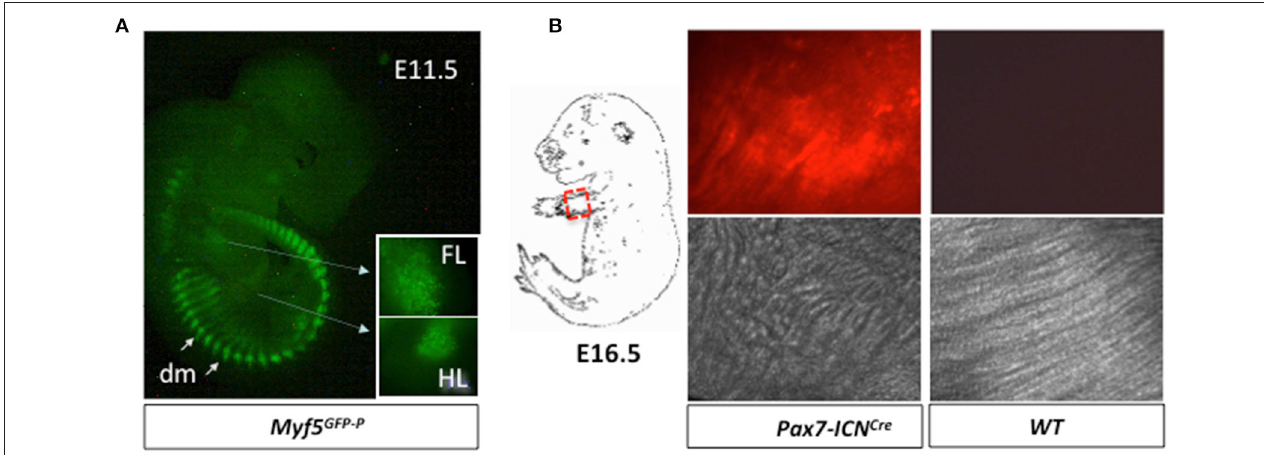
FIGURE 3 | Identification of embryos and fetuses suitable for progenitor purification. (A) Green fluorescence in the myotome/dermomyotome (dm), fore (FL), and hind (HL) limbs of an E11.5 Myf5 GFP − P / + embryo. (B) Limbs of E16. 5 Pax7-ICN Cre / wt ; Z/RED mut / wt and WT fetuses (dashed line) were squeezed between two microscope slides, and red fluorescence was evaluated. Note that muscle fibers, which are clearly apparent in the bright field (lower), are fluorescent only in Pax7-ICN Cre / wt ; Z/RED mut / wt fetuses (upper).